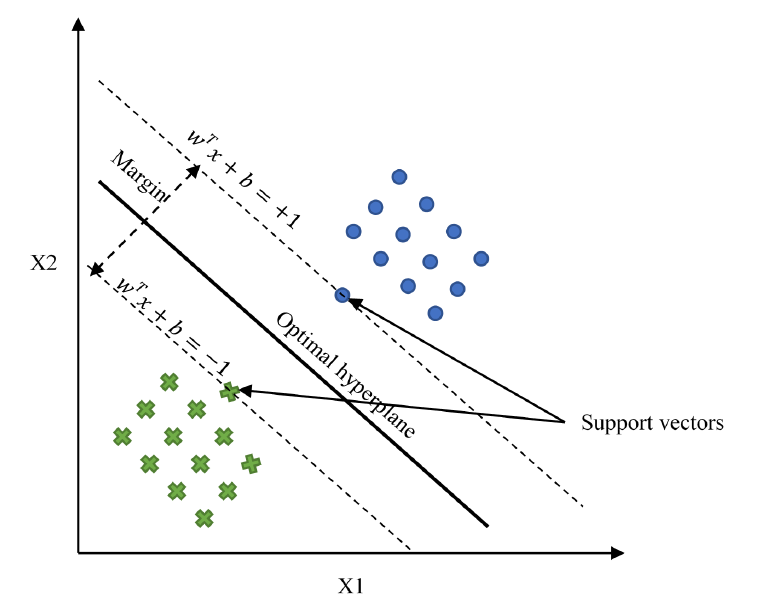
Figure 7. Illustration of binary SVM